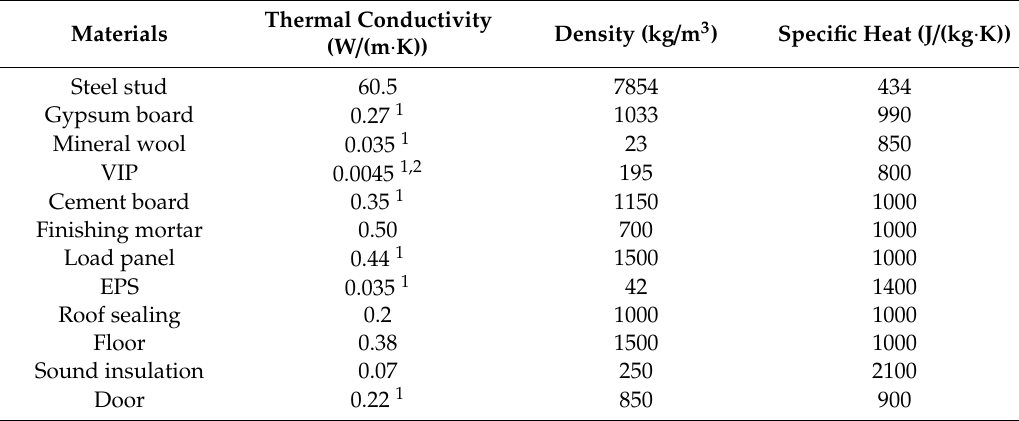
Table 2. The thermal properties of the